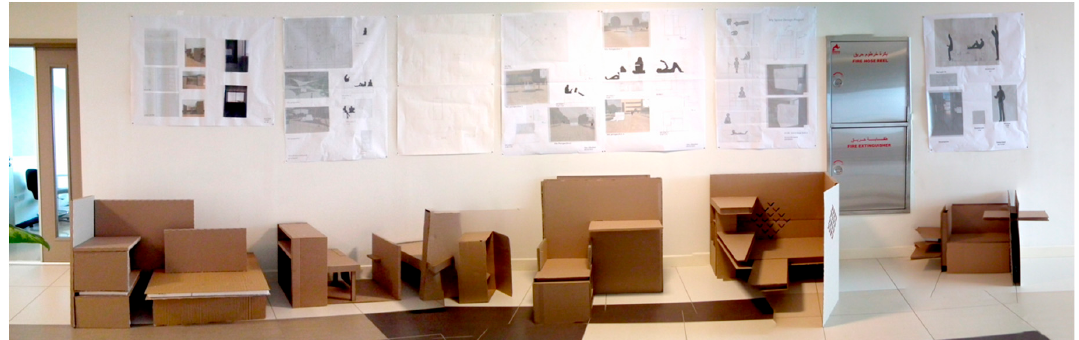
Figure 11. Final presentation session at the end of the term.